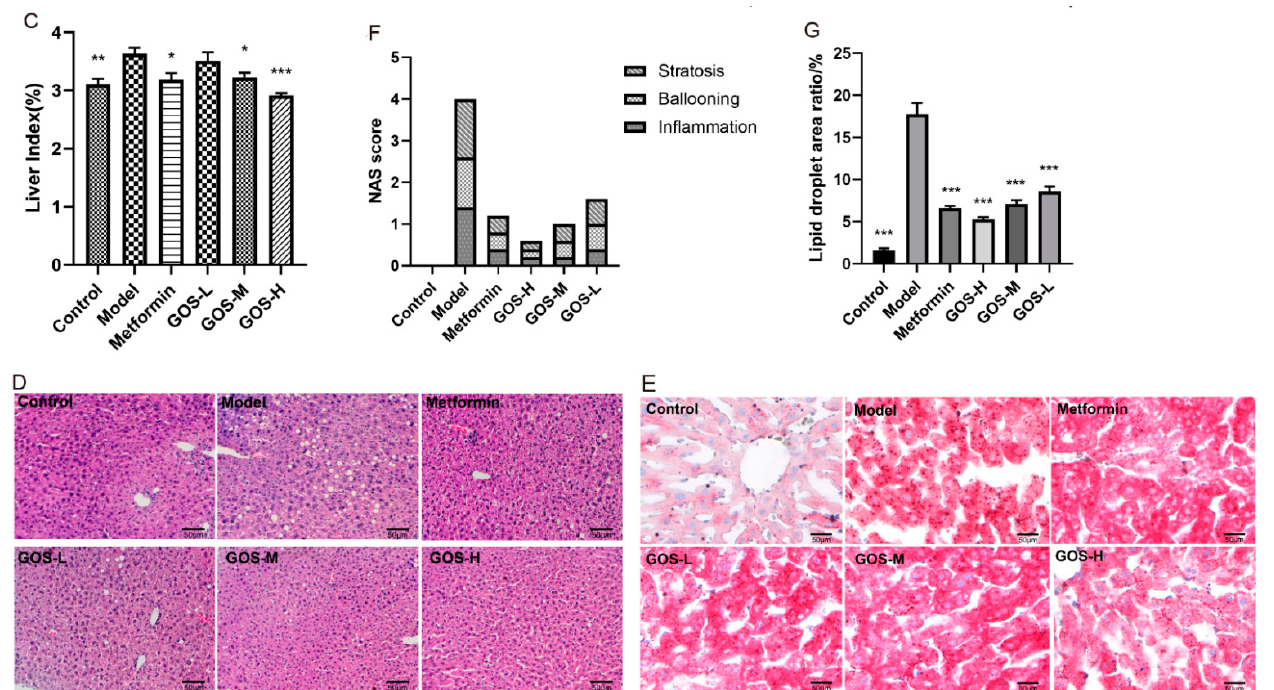
Figure 4. ( A ) Changes in the levels of TC ( a ), TG ( b ), LDL-C ( c ), and HDL-C ( d ) in the liver of rats after administration. ( B ) Changes in the levels of MDA ( a ), SOD ( b ), GSH-Px ( c ), and CAT ( d ) in the liver of mice after administration. ( C ) Mice liver index after administration. ( D , E ) H&E staining and oil red O staining (200 × , scale bar 50 µ m) ( n = 10, mean ± SEM). ( F ) Mice NAS scoring ( n = 5). ( G ) The ratio of lipid accumulation area to total liver area in the liver ( n = 5, mean ± SEM). Note: * p < 0.05, ** p < 0.01, *** p < 0.001 vs. the model